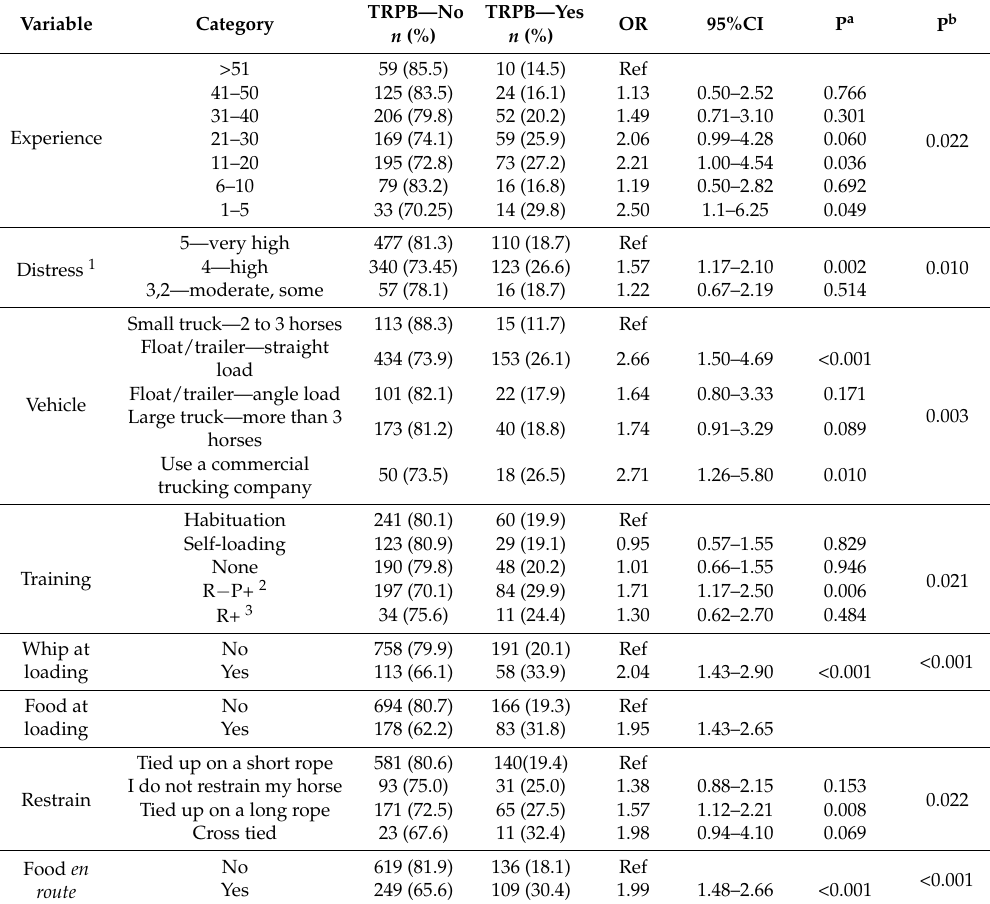
Table 4. Results of univariate logistic regression analyses of associations between TRPBs and the explanatory variables, experience in horse handling, ability to recognize distress in horses, vehicle, type of training used to teach horses to load and travel, use of the whip or food at loading, type of restraint and feeding en route . Data were collected from an online survey on horse road transport in New Zealand ( n = 1124) for movements occurring between 2015 and 2017 (OR: odds ratios; CI: confidence intervals; P a : LRT P value; P b : Wald test P